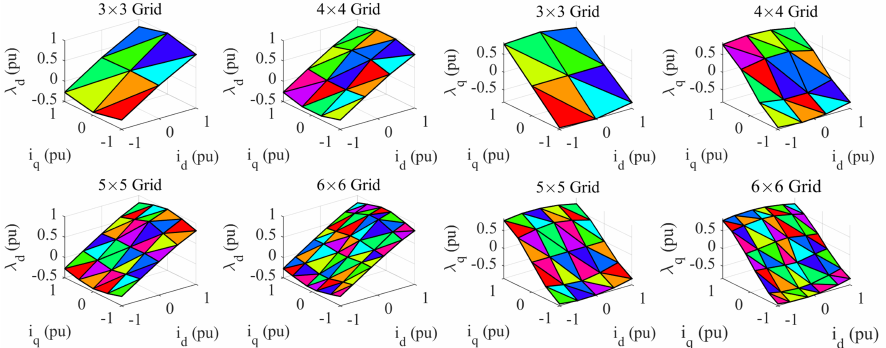
Figure 7. PWA MM functions at various resolutions using regularly gridded I P : (left) d-axis flux λ d from f PWA and (right) q-axis flux λ d